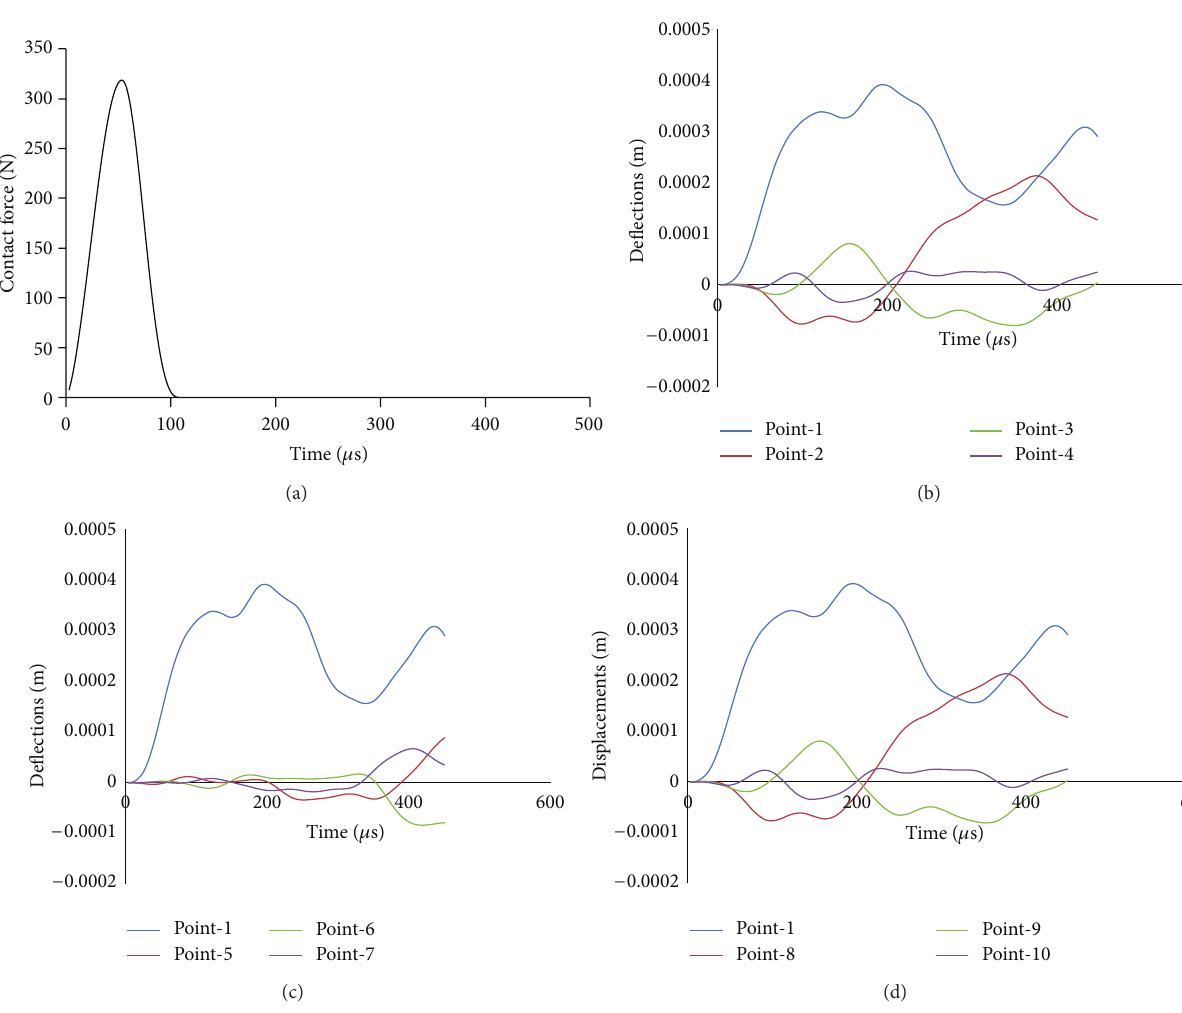
Figure 4: Impact response of clamped cross ply (CL/CP) composite hypar shells for impact velocity